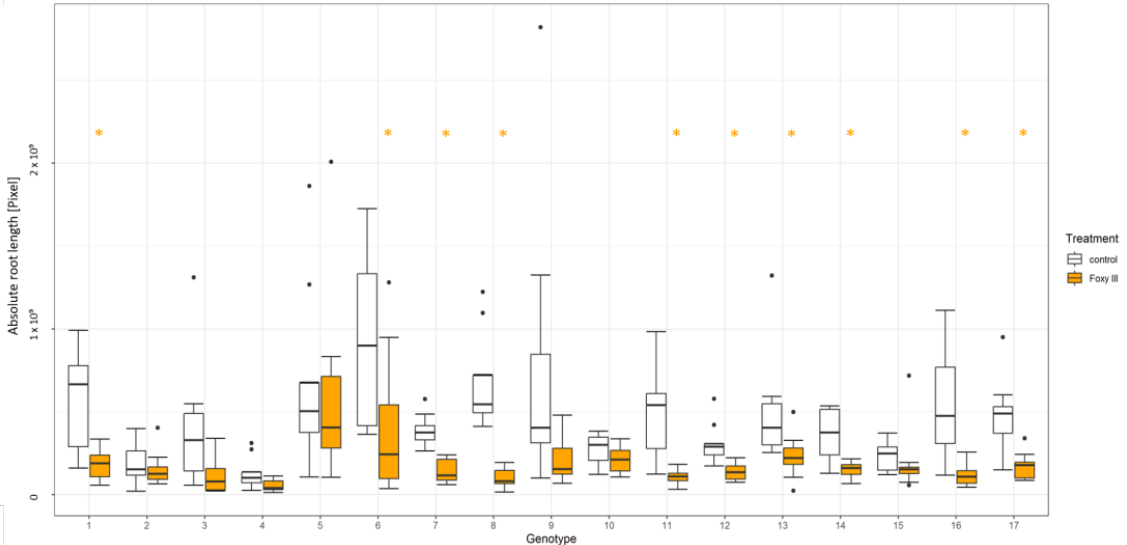
Figure 2. Comparison of absolute root growth 14 dpi with Foxy III of the 18 asparagus genotypes (Table 1) in pixel. * Indicates significance between control (white) and Foxy III (orange) for each genotype ( p < 0.05).